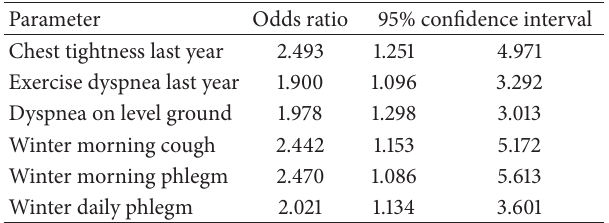
Table 4: Odds ratios of respiratory complaints in tear gas exposed